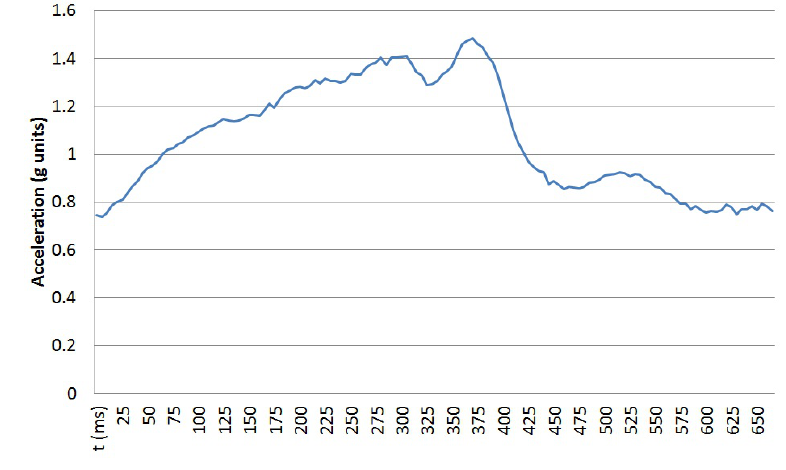
Figure 1. Vertical acceleration in a single step.